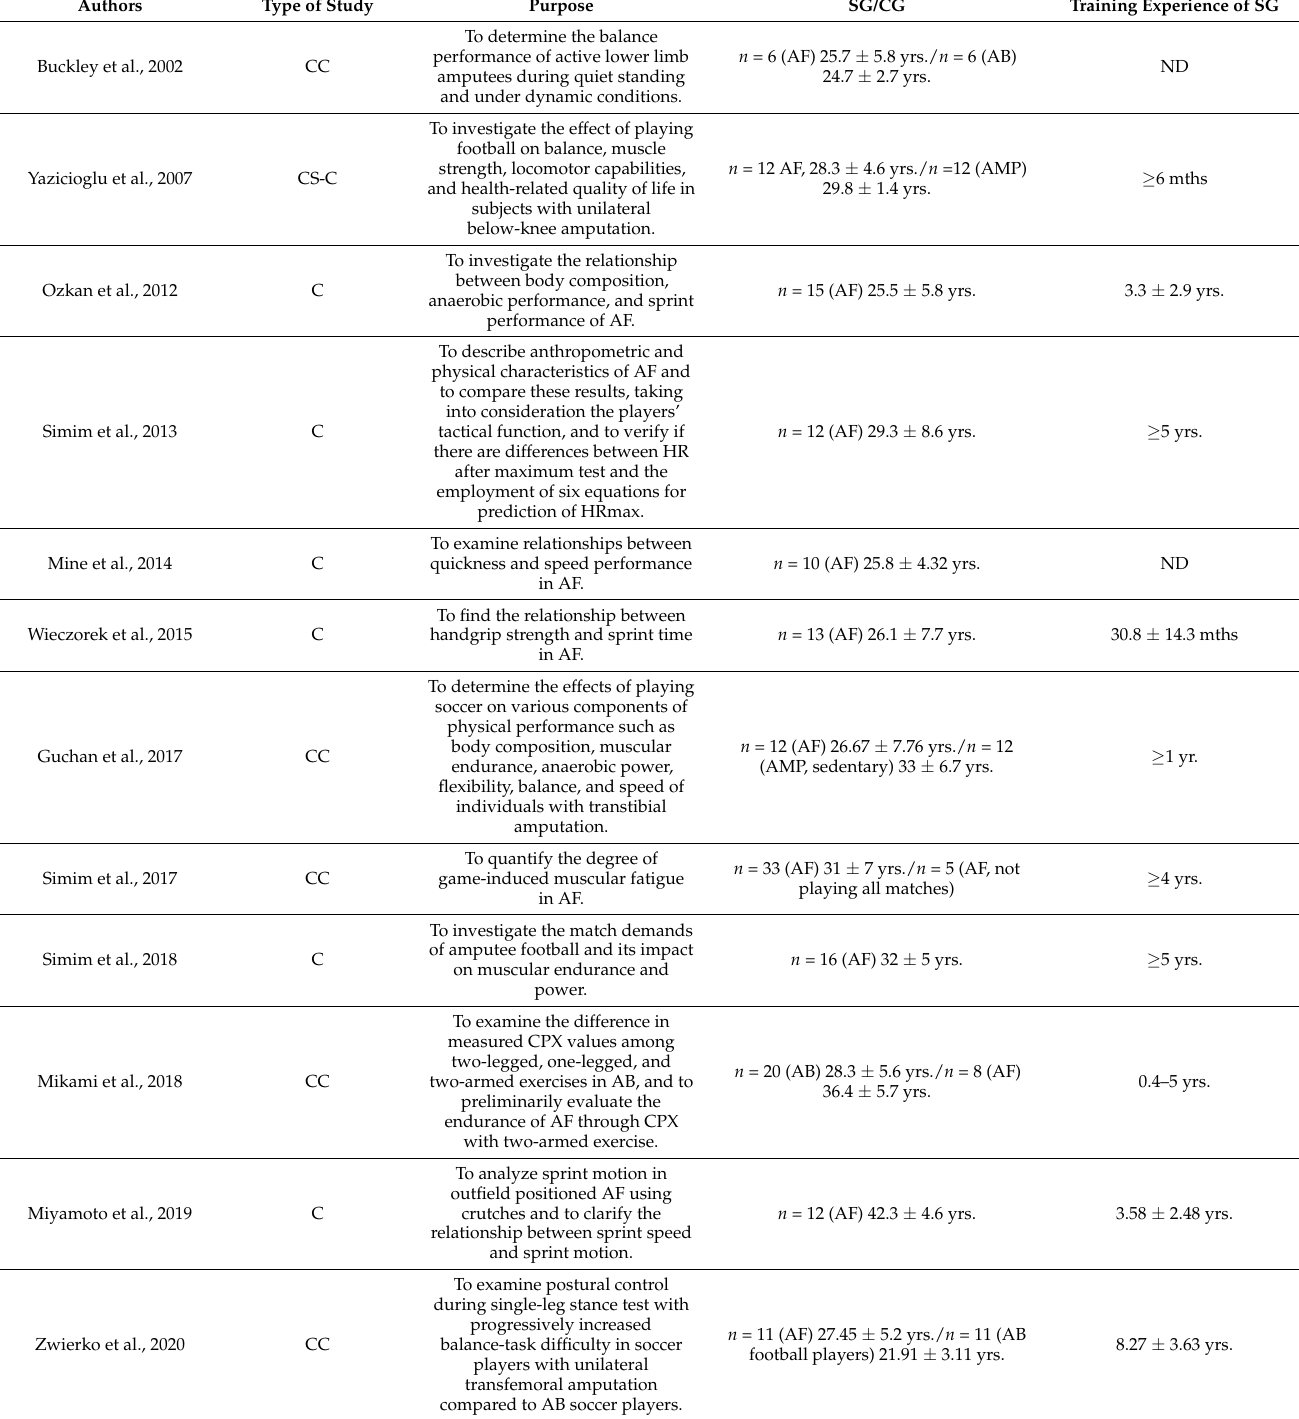
Table 1. General description of included studies ( n = 12; studies arranged in chronological